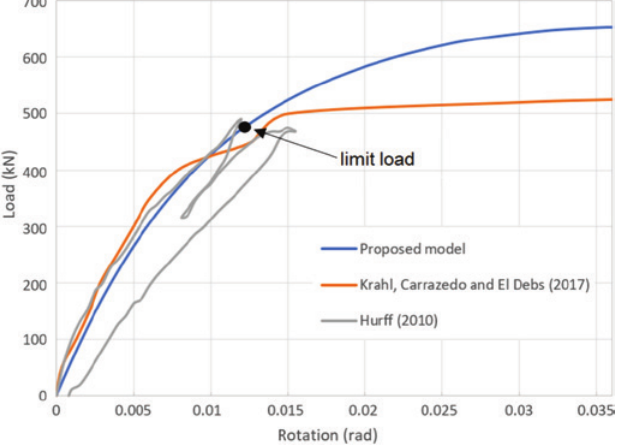
Curve Load × Beam Rotation BT-54